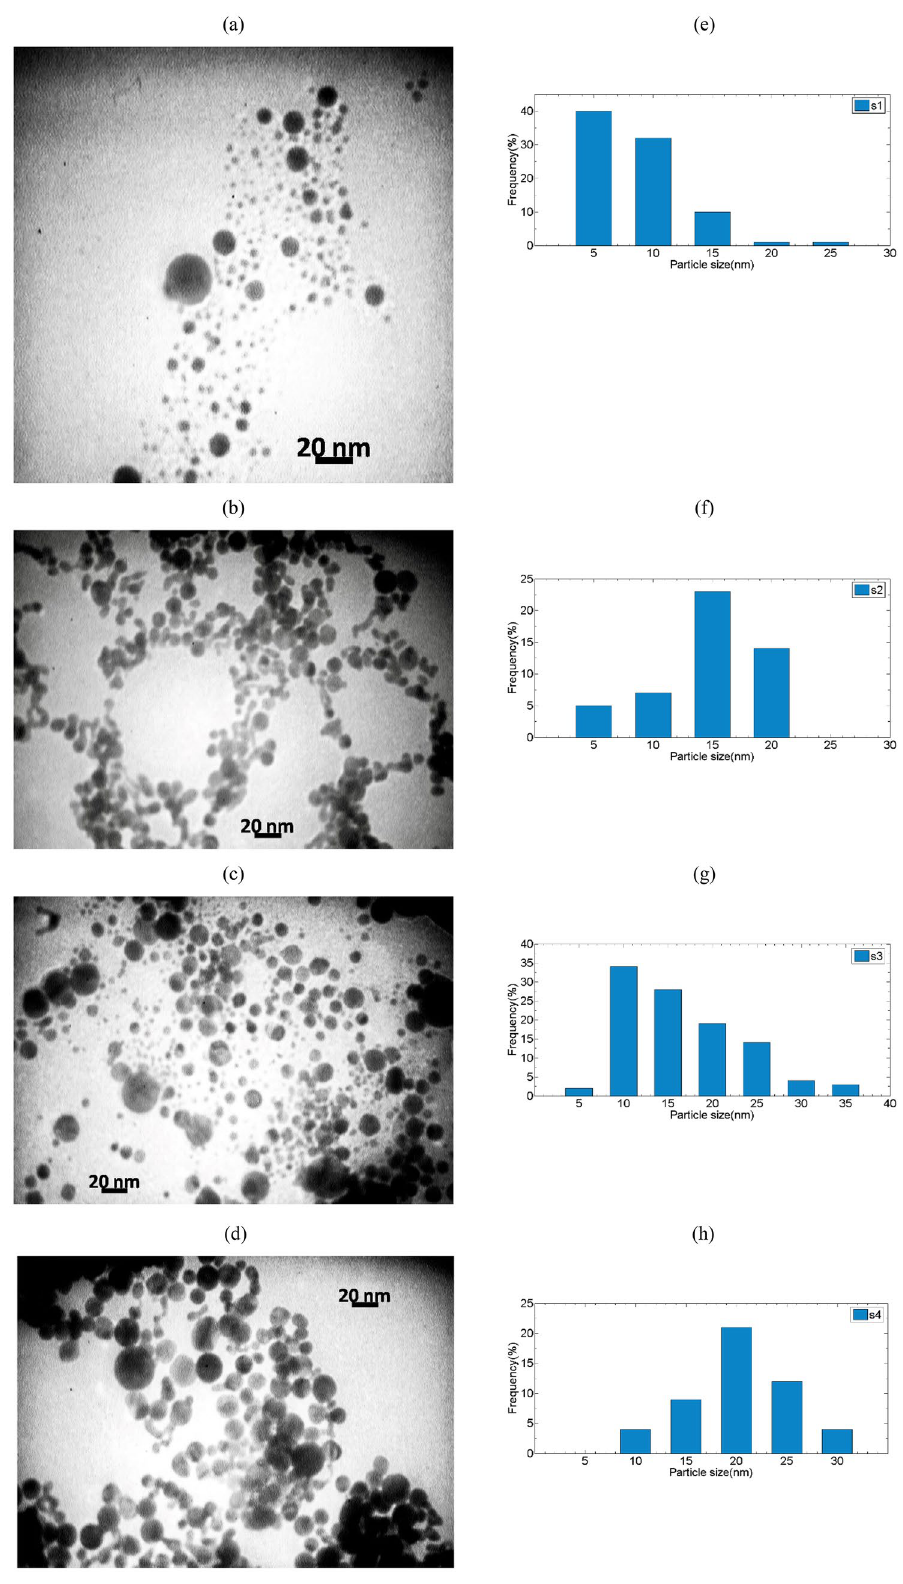
a , AgAu b 2 Au d . e to h 2